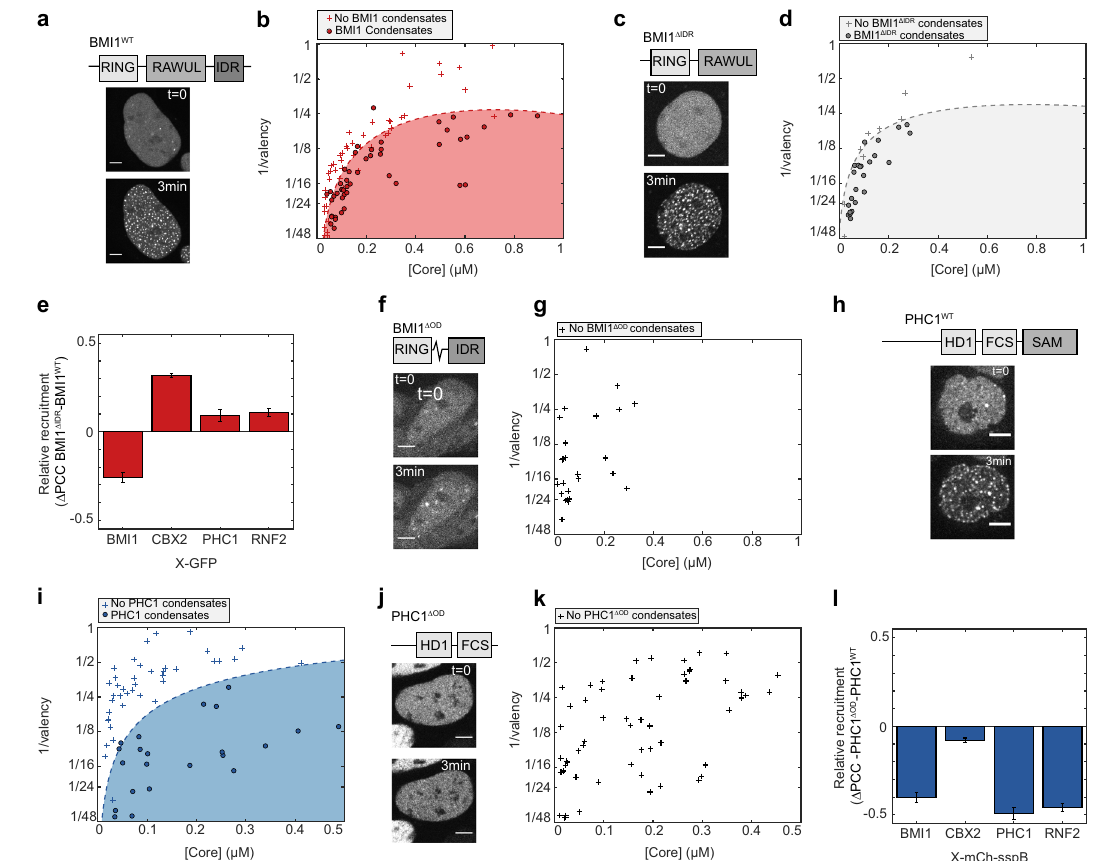
Fig. 3 Hetero-oligomerization contributes to condensate formation. a Domain architecture of BMI1 WT (top). Images show BMI1 WT -mCh-sspB in HEK293 cells with NLS-Ferritin-Corelet before ( t = 0) and after blue light activation (3 min). Scale bar is 5 µ m. b Phase-diagram of BMI1 WT . Filled red circles are phase-separated cells, red pluses are non-phase-separated cells. c Domain architecture of BMI1 Δ IDR (top). Images show BMI1 Δ IDR -mCh-sspB in HEK293 cells with NLS-Ferritin-Corelet before ( t = 0) and after blue light activation (3 min). Scale bar is 5 µ m. d Phase-diagram of BMI1 Δ IDR . Filled grey circles are phase-separated cells, grey pluses are non-phase-separated cells. e Relative change in recruitment of PRC1-GFP fusions for BMI1 WT ( n = 3/7/9/6 for BMI1/CBX2/PHC1/RNF2) and BMI1 Δ IDR ( n = 3/3/3/3 for BMI1/CBX2/PHC1/RNF2). Self-interactions are decreased for BMI1 Δ IDR (as indicated by negative Δ PCC), but recruitment of CBX2-GFP is slightly increased (positive Δ PCC). Recruitment of PHC1 and RNF2 shows little change ( Δ PCC close to zero). Data represented as difference + / − standard error of the difference. f Domain architecture of BMI1 Δ OD (top). Images show BMI1 Δ OD -mCh-sspB in HEK293 cells with NLS-Ferritin-Corelet before ( t = 0) and after blue light activation (3 min). Scale bar is 5 µ m. g Phase-diagram of BMI1 Δ OD , showing that BMI1 Δ OD does not phase-separate in this regime. h Domain architecture of PHC1 WT (top). Images show PHC1 WT -mCh-sspB in HEK293 cells with NLS- Ferritin-Corelet before ( t = 0) and after blue light activation (3 min). Scale bar is 5 µ m. i Phase diagram of PHC1 WT . Filled blue circles are phase-separated cells and blue pluses are non-phase separated cells. j Domain architecture of PHC1 Δ OD (top). Images show PHC1 Δ OD -mCh-sspB in HEK293 cells with NLS- Ferritin-Corelet before ( t = 0) and after blue light activation (3 min). Scale bar 5 µ m. k Phase diagram for PHC1 Δ OD , showing that PHC1 Δ OD does not phase-separate in this regime. l Relative change in recruitment to PRC1-mCh-sspB fusions for PHC1 WT ( n = 9/4/6/5 for BMI1/CBX2/PHC1/RNF2) and PHC1 Δ OD ( n = 3/3/4/5 for BMI1/CBX2/PHC1/RNF2). Recruitment of all subunits is decreased for PHC1 Δ OD (negative Δ PCC). Neither PHC1 WT nor PHC1 Δ OD recruits CBX2 ( Δ PCC near zero). Data represented as difference + / − standard error of the difference.